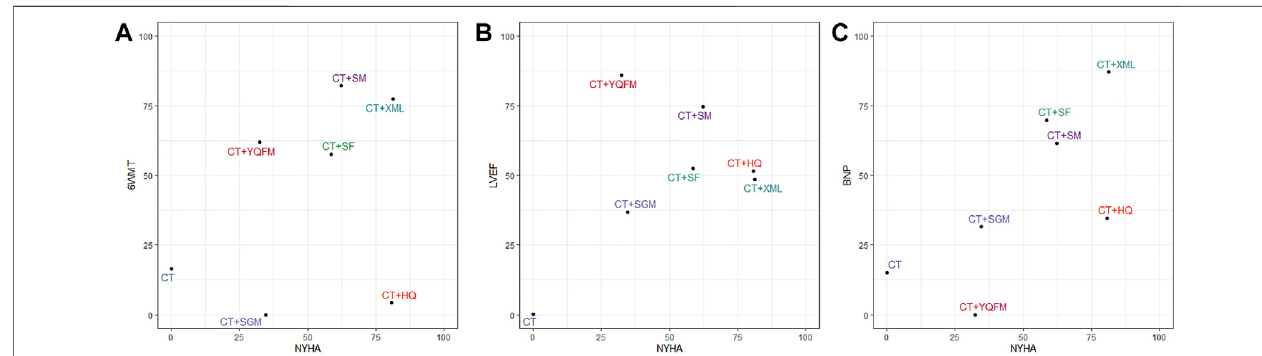
FIGURE 5 | Multi-dimensional ef fi cacy analysis results. (A) NYHA and 6WMT; (B) NYHA and LVEF; (C) NYHA and BNP. Interventions located in the upper right corner indicate optimal therapy for two different outcomes. NYHA, New York Heart Association cardiac functional classi fi cation ef fi ciency; 6WMT, 6-min walking test; LVEF,leftventricularejectionfraction;BNP,brainnatriuretic peptide; CT,conventional treatment;HQ,Huangqiinjection; SF, Shenfu injection; SGM,Shengmai injection; SM, Shenmai injection; XML, Xinmailong injection; YQFM, Yiqifumai lyophilized injection.